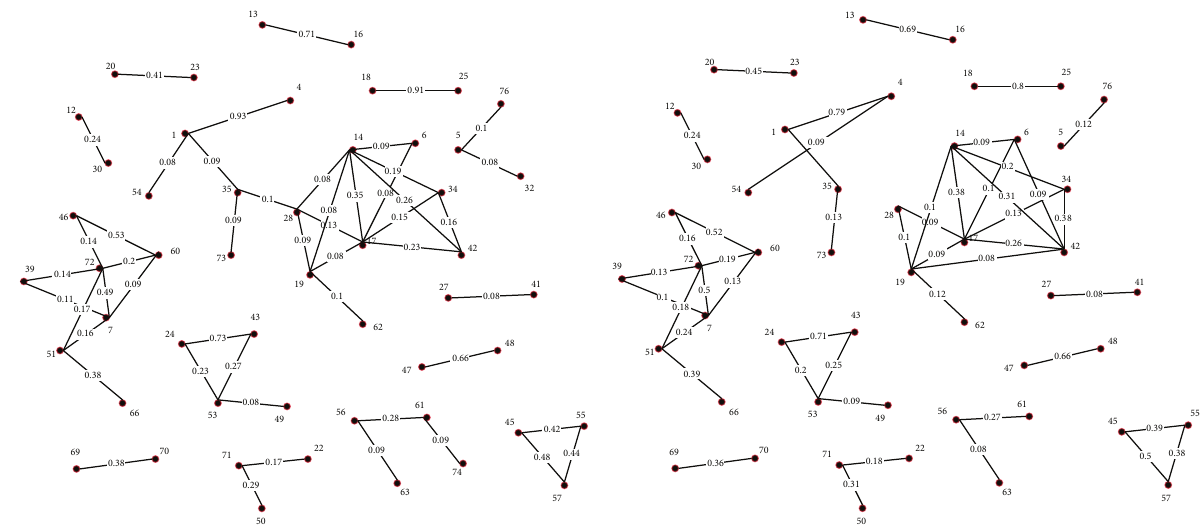
(b) Meaningful social relationships in IHC’s synthetic trace ( 𝑇 th > 20000) Figure 8: Comparisons between Infocom 06 trace and IHC: meaningful social relationships.